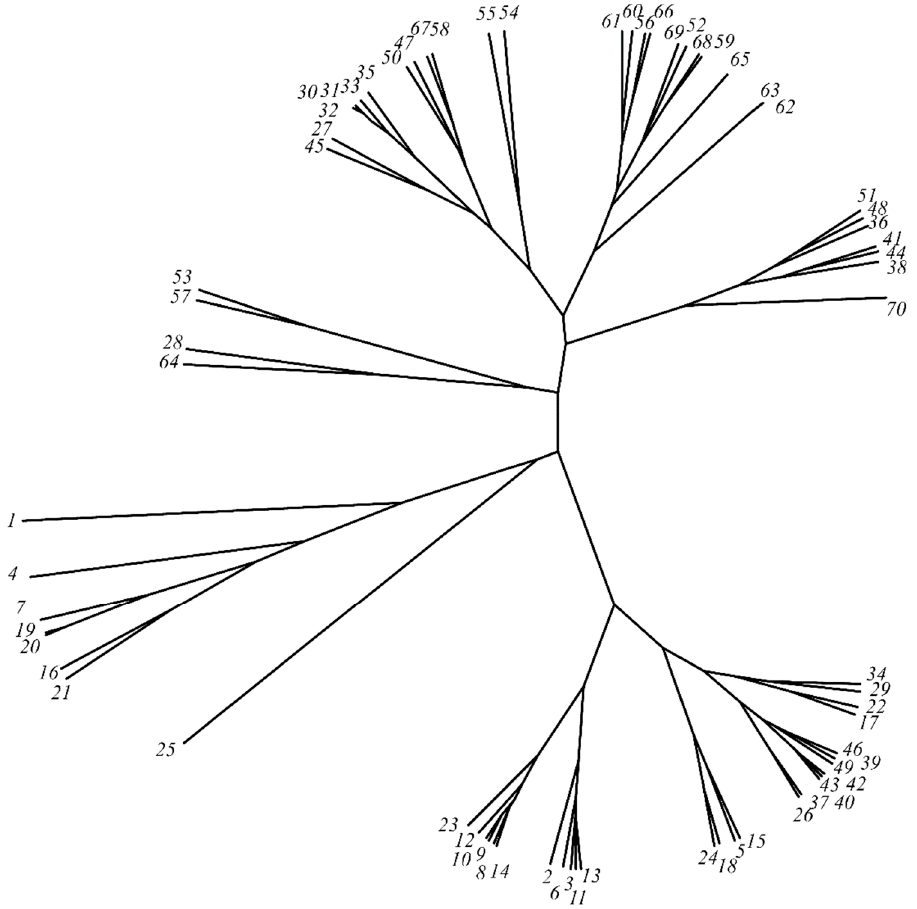
Figure 2. Unrooted cluster tree for different Hyssopus officinalis samples.